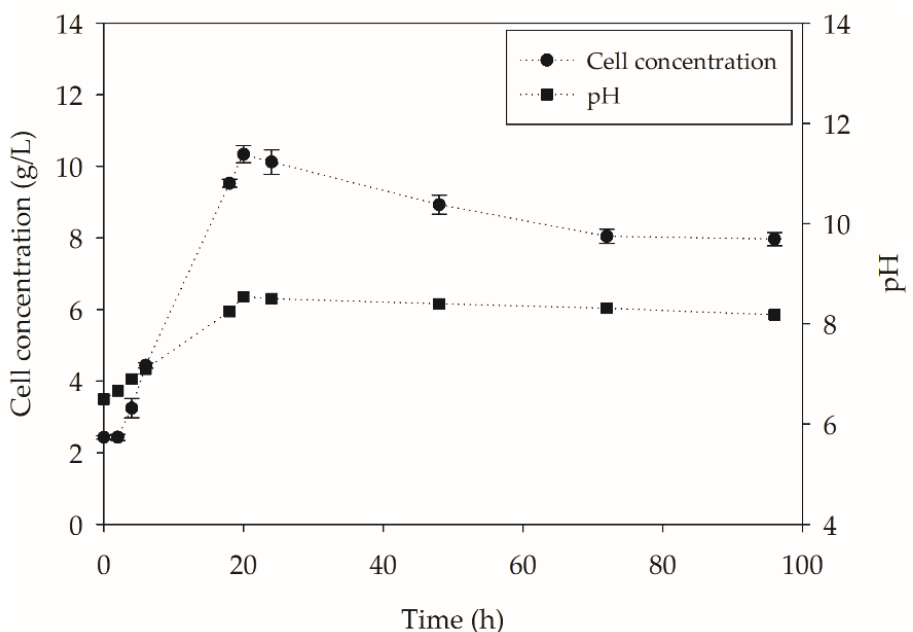
Figure 9. Y. lipolytica IMUFRJ 50682 growth and pH variation in the bioreactors (450 rpm, 1 vvm and 28 °C) containing YT medium + PC-PET (500 mg/L) over 96 h.